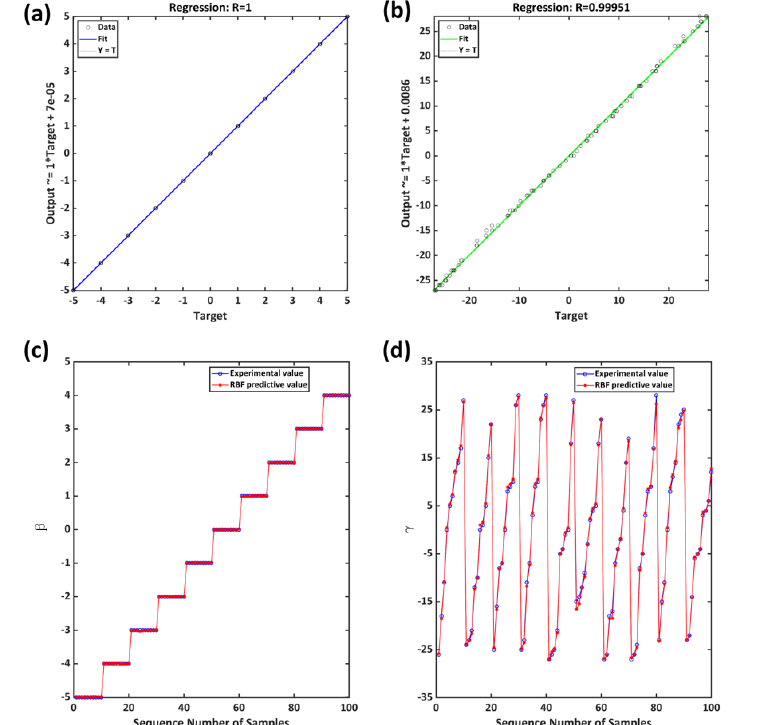
Figure 13. Analysis of RBF network output. ( a ) Regression analysis of β . ( b ) Regression analysis of γ . ( c ) The error comparison of β . ( d ) The error comparison of γ